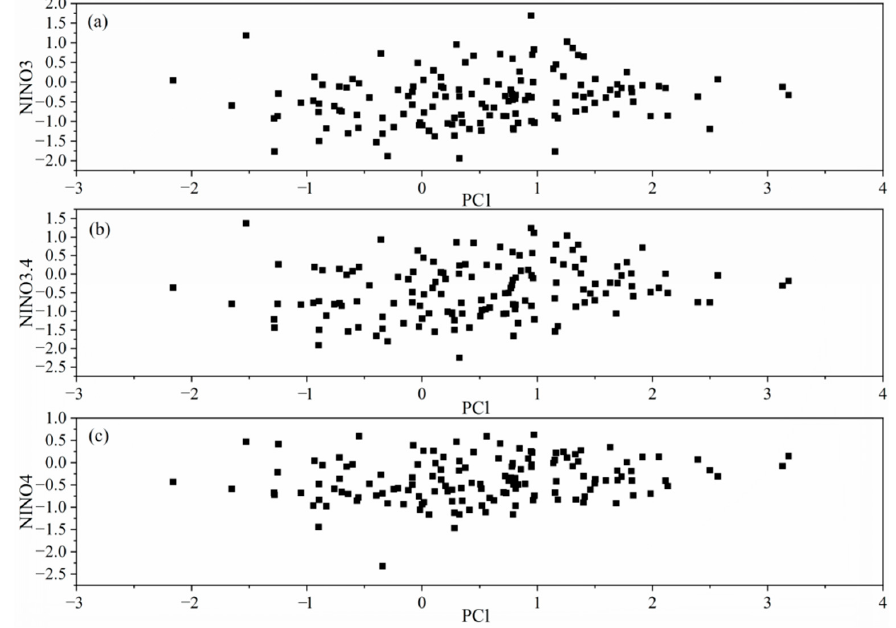
Figure 8. Scatter diagrams between PC1 and the ( a ) NINO3, ( b ) NINO3.4, and ( c ) NINO4 indices.